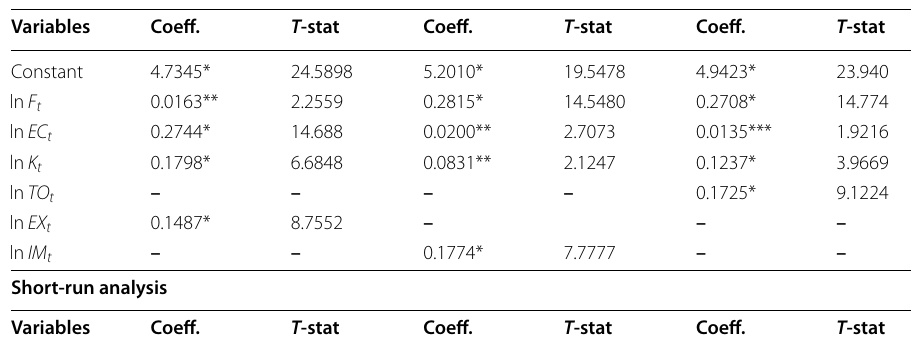
Table 6 Long- and short-run results (dependent variable Long run